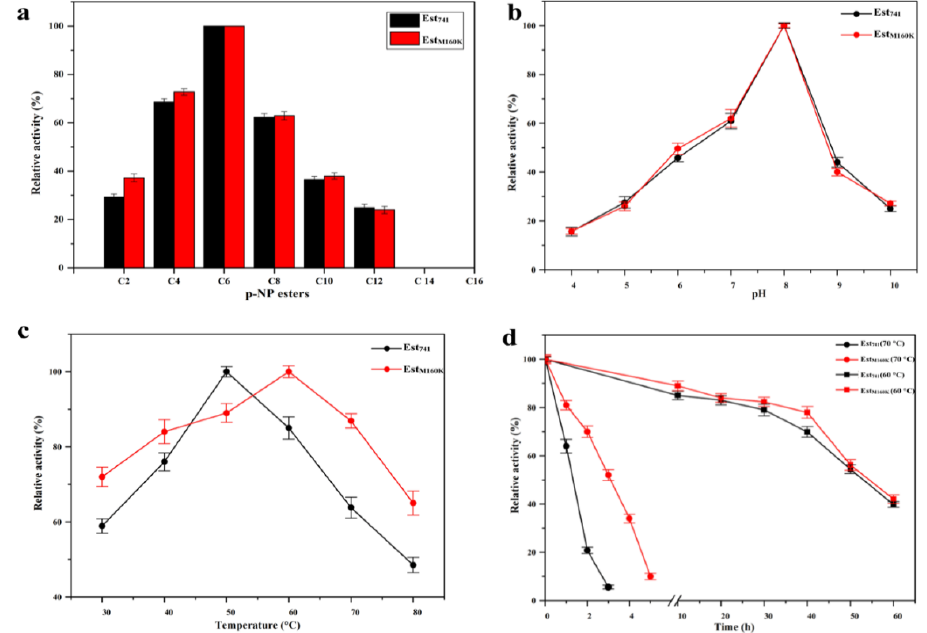
Figure 2. Characterization of Est 741 and Est M160K . ( a ) E ff ect of p-nitrophenyl (p-NP) esters of di ff erent chain lengths on the activities of Est 741 and Est M160K . ( b ) E ff ect of pH on the activities of Est 741 and Est M160K . ( c ) E ff ect of temperature on the activities of Est 741 and Est M160K . ( d ) Thermal stabilities of Est 741 and Est M160K at 60 and 70 ◦ C.